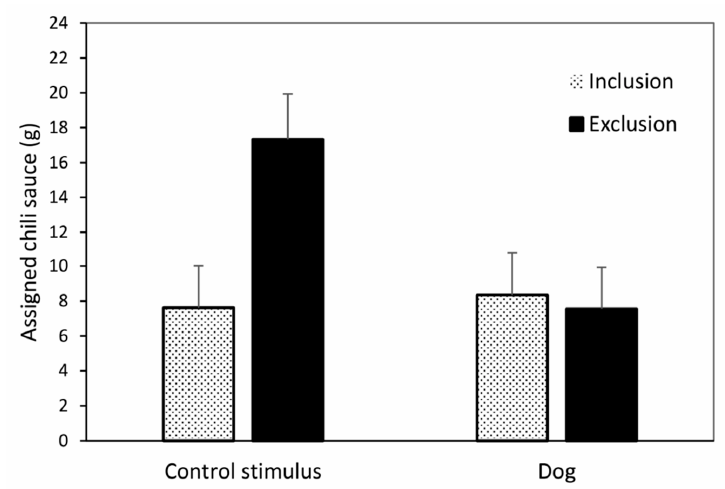
Figure 2. Impact of presence of a dog on exclusion-related antisocial behavior. Amount of hot sauce assigned to the putative perpetrator following social exclusion or inclusion. Significant interaction effect of prior exclusion/inclusion by presence of dog/control stimulus. Whiskers denote standard errors.